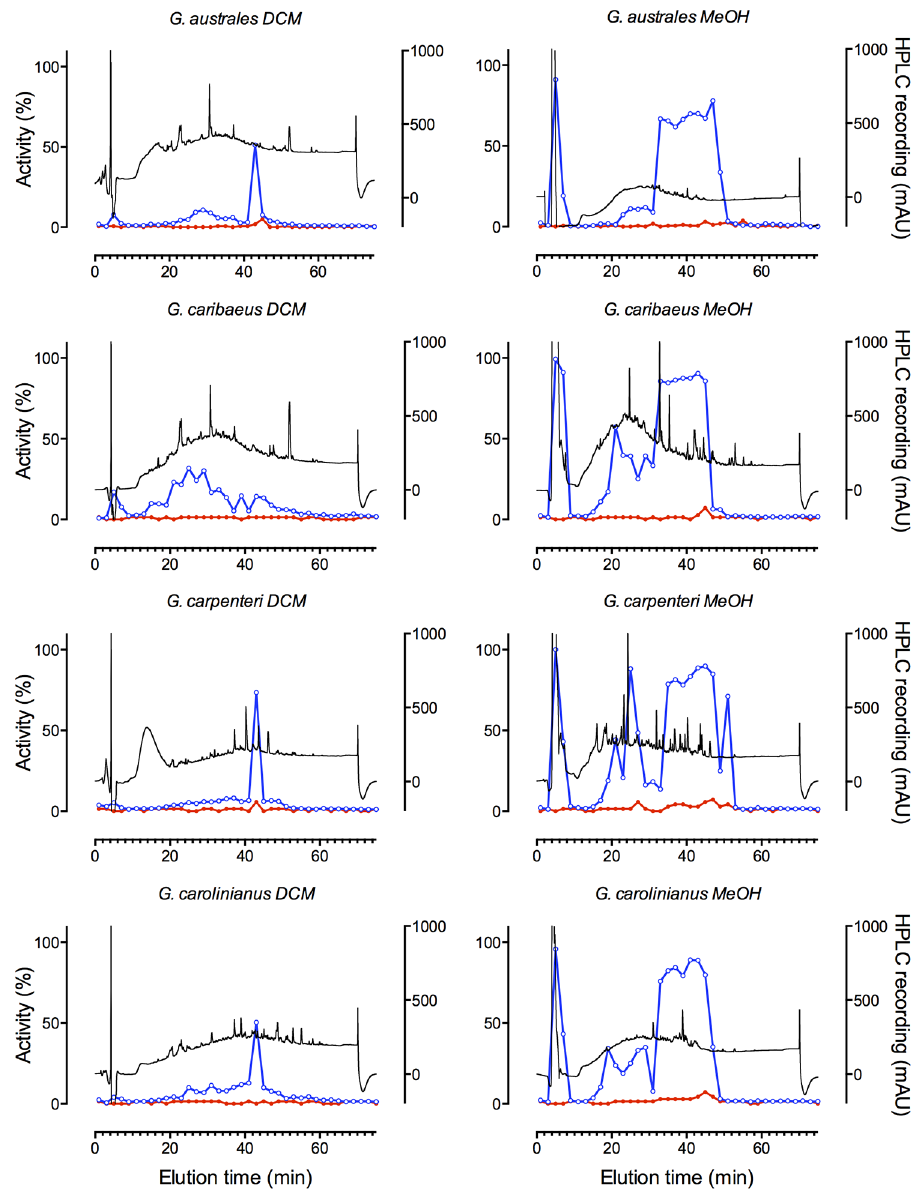
Fig 5. CTX-like and MTX-like activity in HPLC fractionated Gambierdiscus extracts of Pacific isolates. Dichloromethane (DCM) and methanol (MeOH) extracts of G . australes (W B Gam 3), Hawaii G . caribaeus (Pat HI Jar 2 Gam 2), G . carpenteri (Pat HI Jar 7 Gam 11), and G . carolinianus (Pat HI Jar 3 Gam) were fractionated by HPLC with MS UV detection (black trace). Fractions were tested for activity using the FLIPR TETRA assay. CTX-like (red trace) and MTX-like (blue trace) activity was expressed as percent activity (%) relative to the most active MTX and CTX-containing fraction tested in this